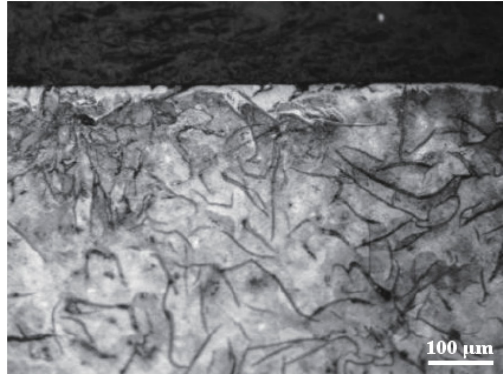
Figure 10. Optical Figure 10. Optical micrograph.